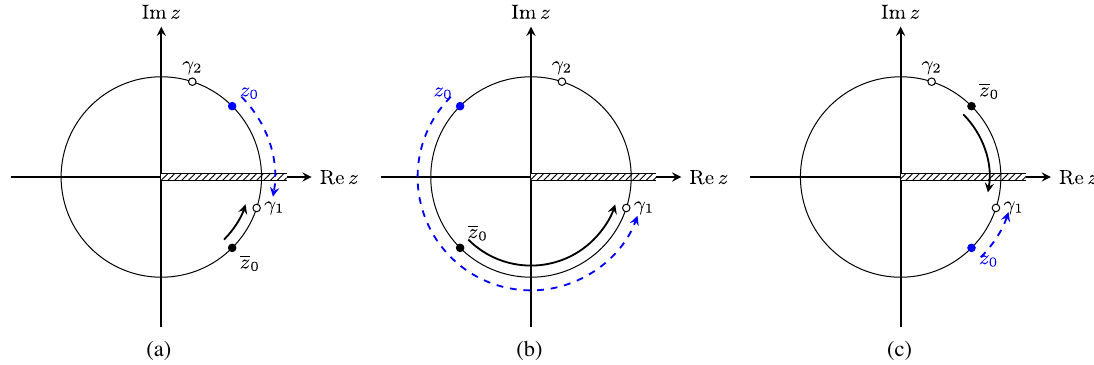
and ¯ z on a unit circle. Hollow dots are the fixed points, from which we n n < x . Blue and black dots are the initial positions of z and ¯ z , C A n n and ¯ z in each cycle wind around the unit circle counterclockwise and stop at the next position, with n n has a relative branch cut crossing to ¯ z ; therefore, they stay on the same n n < x < x . Neither line crosses the branch cut; thus, z and ¯ z remain on different sheets. C A n n and ¯ z still end up getting on the same Riemann n n